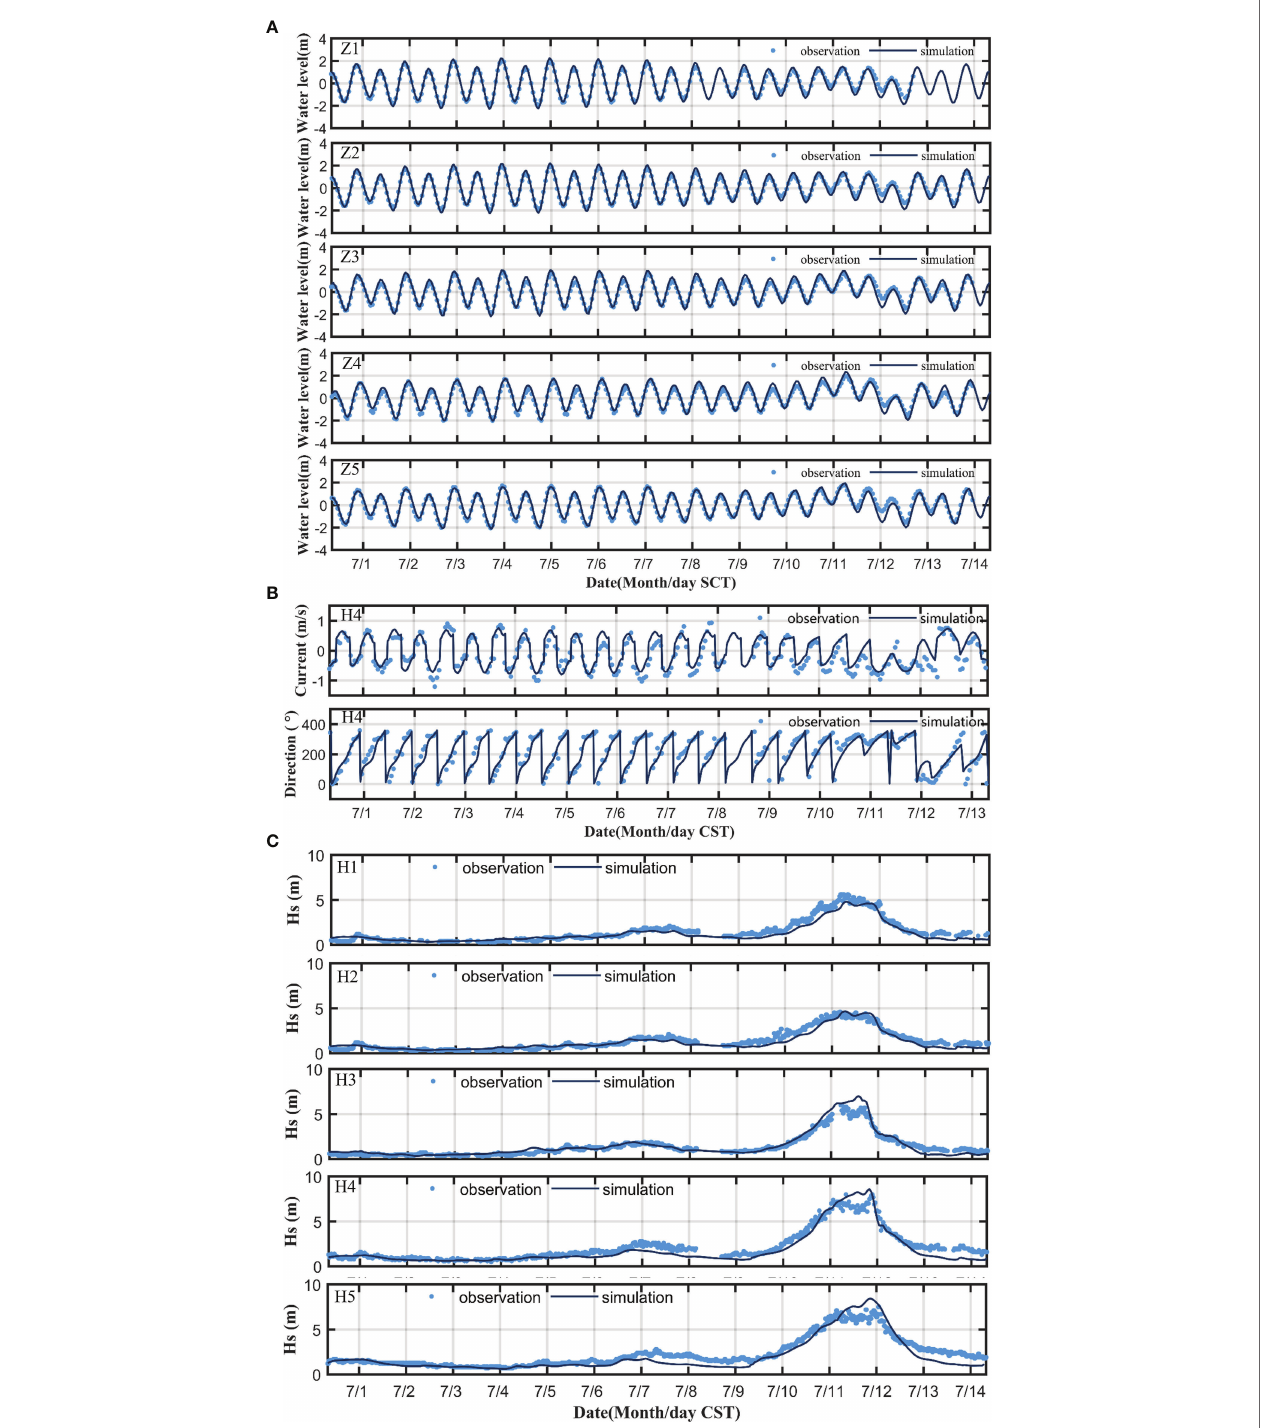
FIGURE 3 | (A) Comparison of simulated and observed water levels at Z1 to Z5 stations. (B) Current speed and current direction at H4 station. (C) Comparison of simulated and observed signi fi cant wave